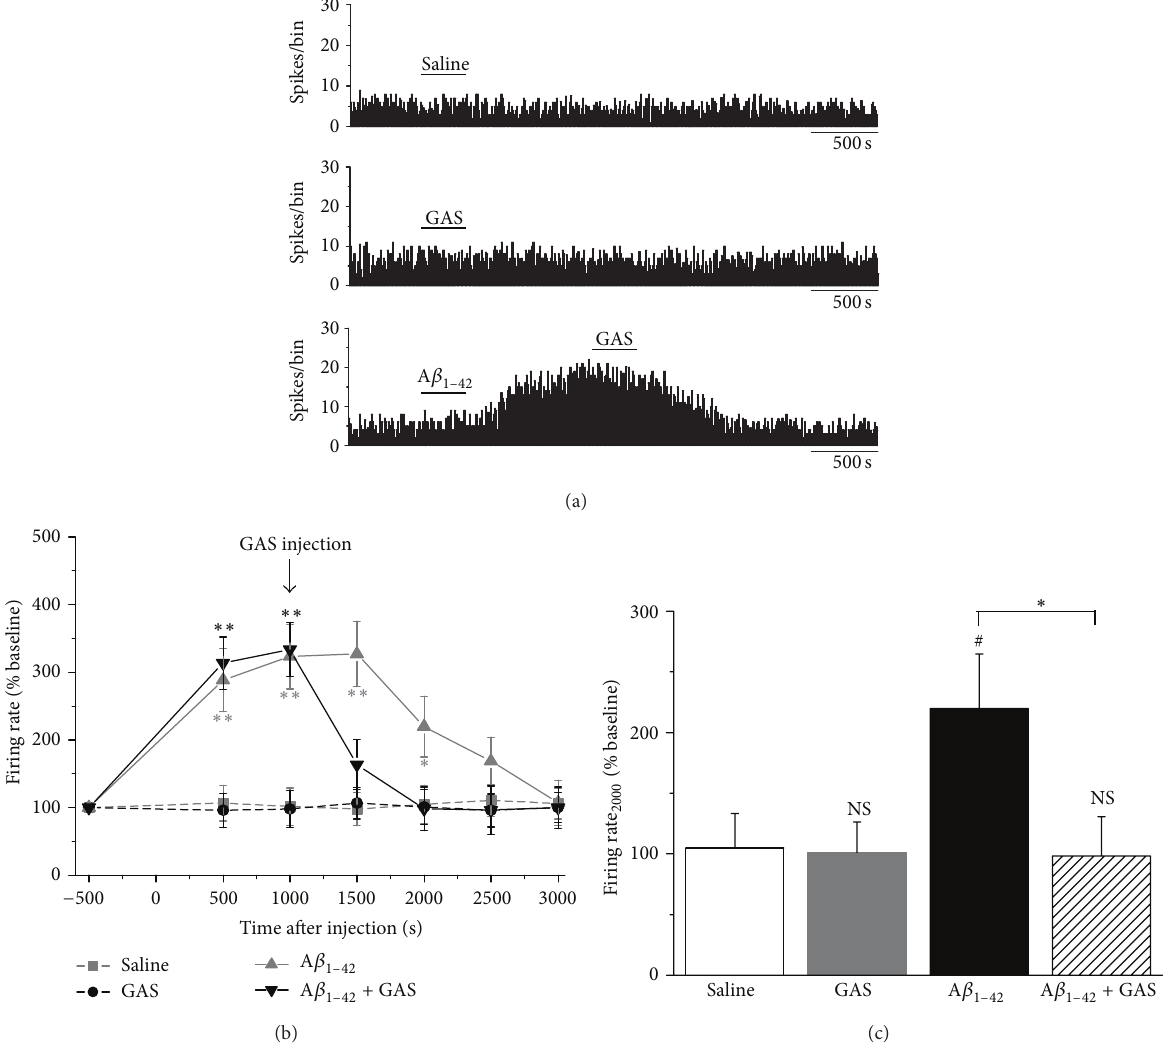
Figure 4: Inhibitory effects of GAS on A 𝛽 1 -induced increase in spontaneous discharge in EC region. (a) Representative traces of firing – 42 plus GAS (lower). Saline or GAS alone did not exert rate of EC neurons after the application of saline (upper), GAS alone (middle), or A 𝛽 1 – 42 -induced hyperexcitation. any obvious effect on the firing activities. Application of the GAS decreased the spontaneous discharge of A 𝛽 1 – 42 alone, and A 𝛽 1 plus GAS groups on the firing rates of EC neurons ( ∗ 𝑃 < 0.05 , (b) Time-response curves for saline, GAS alone, A 𝛽 1 – 42 – 42 ∗∗ 𝑃 < 0.01 versus baseline values). (c) Histograms showing the mean discharge rate of EC neurons in different groups at 2000 s after injection (NS, no significant difference versus vehicle group, # 𝑃 < 0.05 versus saline group, ∗ 𝑃 < 0.05